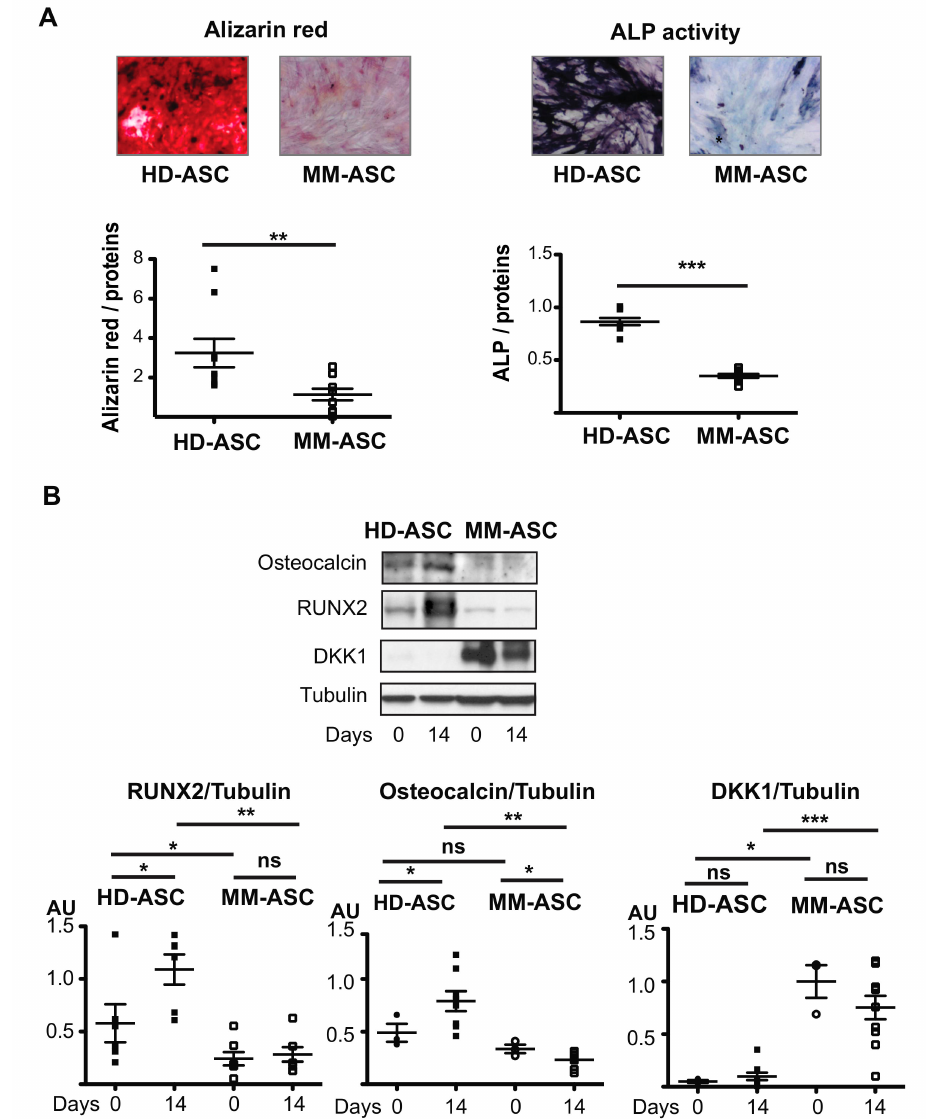
Figure 3. Osteoblast di ff erentiation is altered in MM patients. ASC were di ff erentiated into osteoblasts for 14 days. ( A ) The cells were stained with Alizarin Red to visualize calcium deposition and representative micrographs and scans are shown (left). Staining was quantified at 560 nm and normalizedtotheproteincontent. Alkalinephosphatase(ALP)activitywasmeasuredandrepresentative micrographs and scans are shown (right). ** p < 0.01, *** p < 0.001, MM-ASCs vs. control cells (HD-ASC). ( B ) Whole cell lysates were extracted on day 0 or 14 of di ff erentiation and analyzed by immunoblotting. Representative immunoblots of osteocalcin, RUNX2, DKK1, and tubulin (loading control) are shown in the upper panel and Western blot quantifications in the two lower panels. * p < 0.05, ** p < 0.01, *** p < 0.001. AU: Arbitrary